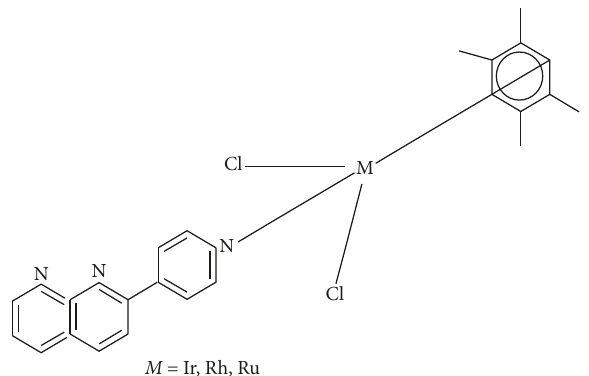
Figure 1: Half-sandwich d 6 metal complexes comprising 2- substituted 1, 8-napthyridine ligands with unexpected bonding